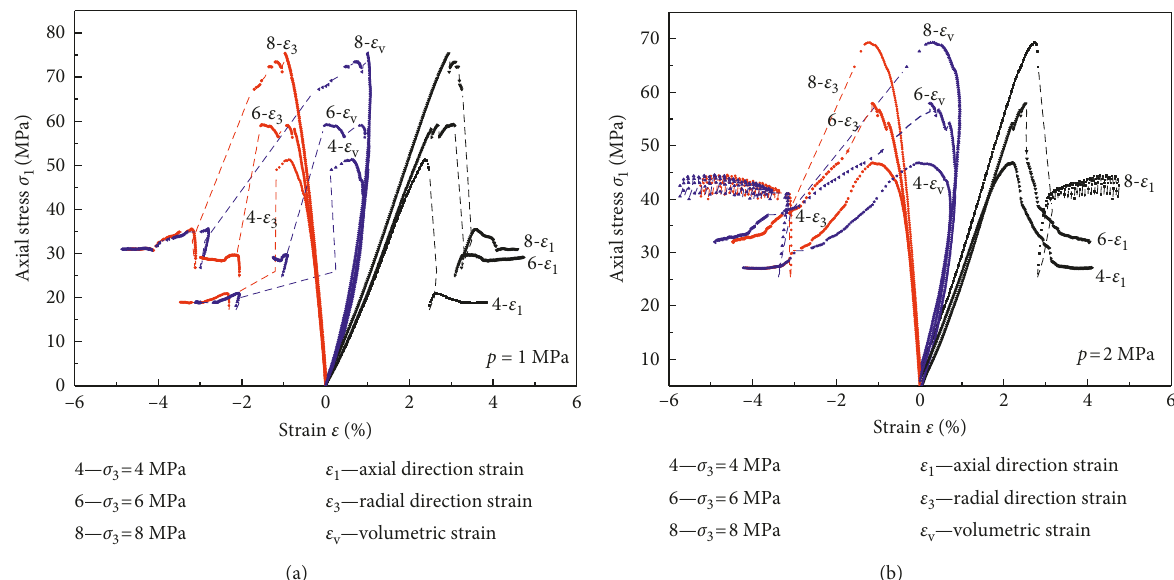
Figure 3: Relationship between axial stress and strain at pore pressures of (a) 1 MPa and (b) 2 MPa.